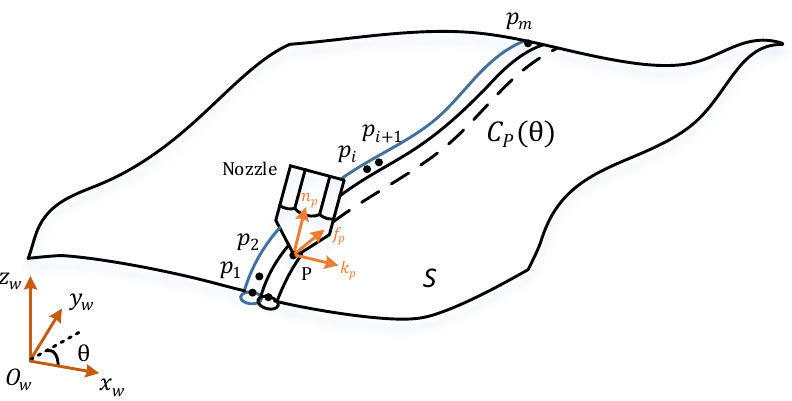
Figure 2. A printing nozzle location (NL) curve defined in WCS and its local frame. In the realm of FDM printing, some previous research [16–19] studied various char- acteristics of the FDM process, and many mathematical models were proposed for the modeling of the geometry of the deposed material. Of all the proposed methods for mod- eling the cross-sectional shape of the deposited filaments, the ellipse model, which was originally proposed by Ahn et al. [17] and subsequently extended by Angelo1 et al. [19] with experimental validation, is commonly adopted. Therefore, the ellipse model is also adopted by us in this paper, which represents the cross-section of adjacent NL curves by two intersected ellipses. It should be mentioned that, for a genuine curved layer, both concave and convex cases should be assumed, thus the two different scenarios of adja- cent filaments as shown in Figure 3. Considering that the modeling ellipse is very small while the printing layer is sufficiently smooth, the curve intersected by the n p - k p plane of point p and the layer surface can be approximated as an arc passing through p . The same approximation can also be applied to the intersection with the previous layer. Thus, the cross-sectional ellipse can be parametrically formulated in the n p - k p plane as: (1) where ρ is the angular parameter measured from the k p -axis, with s and h being the major- axis length and minor-axis length, respectively. In this paper, we assume that s is equal to the nozzle diameter and h is the layer thickness at p .